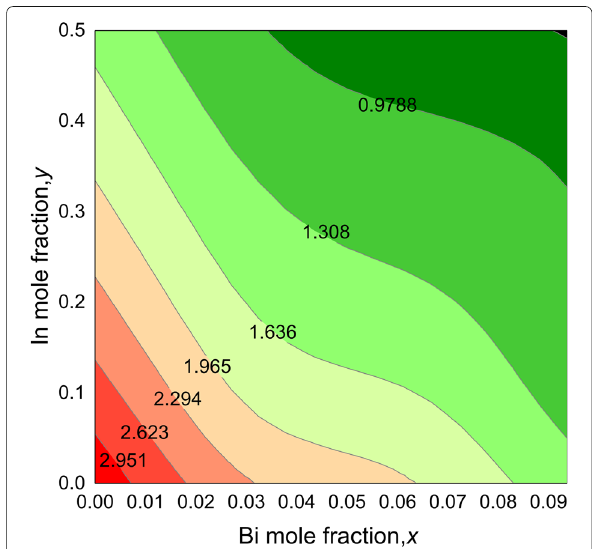
Fig. 4 Contour plot of the bandgap values for In y Ga 1 − y N 1 − x Bi x alloys, as a function of Bi( x ) and In( y ) compositions